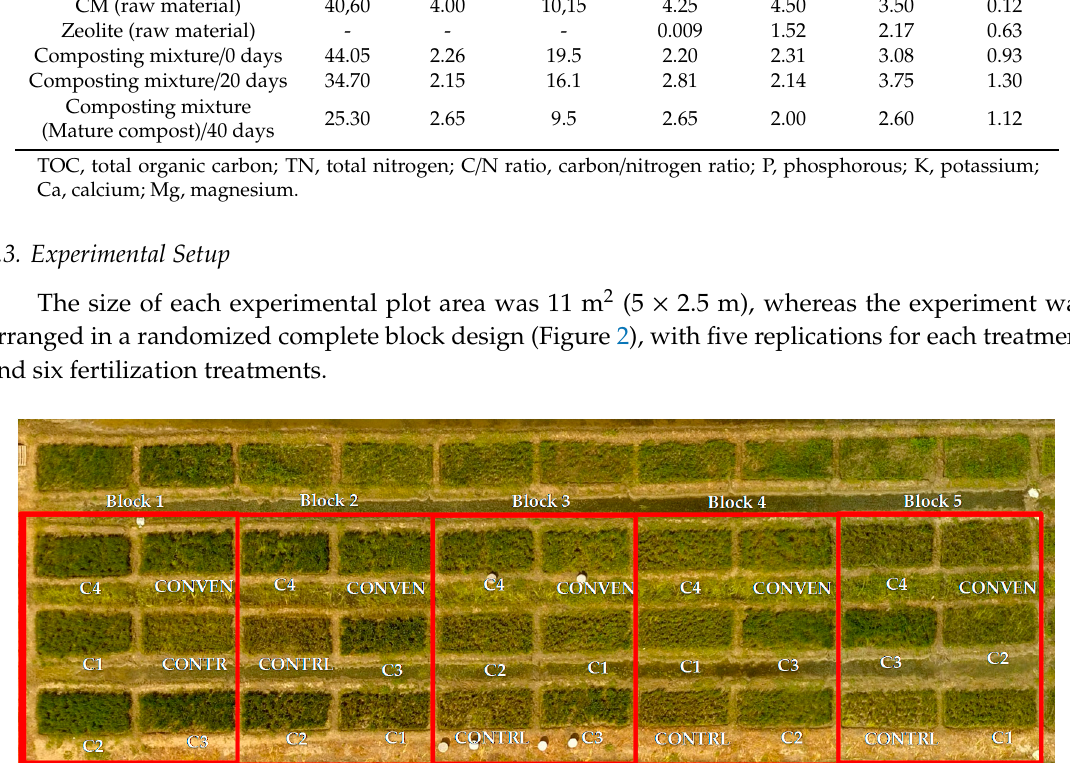
Table 2. Laboratory analysis of the main raw materials (RH, RB, CM, and zeolite), the initial composting mixture at 0 days, and the composting mixture at 20 and 40 days (mature compost), utilized in 2017 and 2018 experimentation.